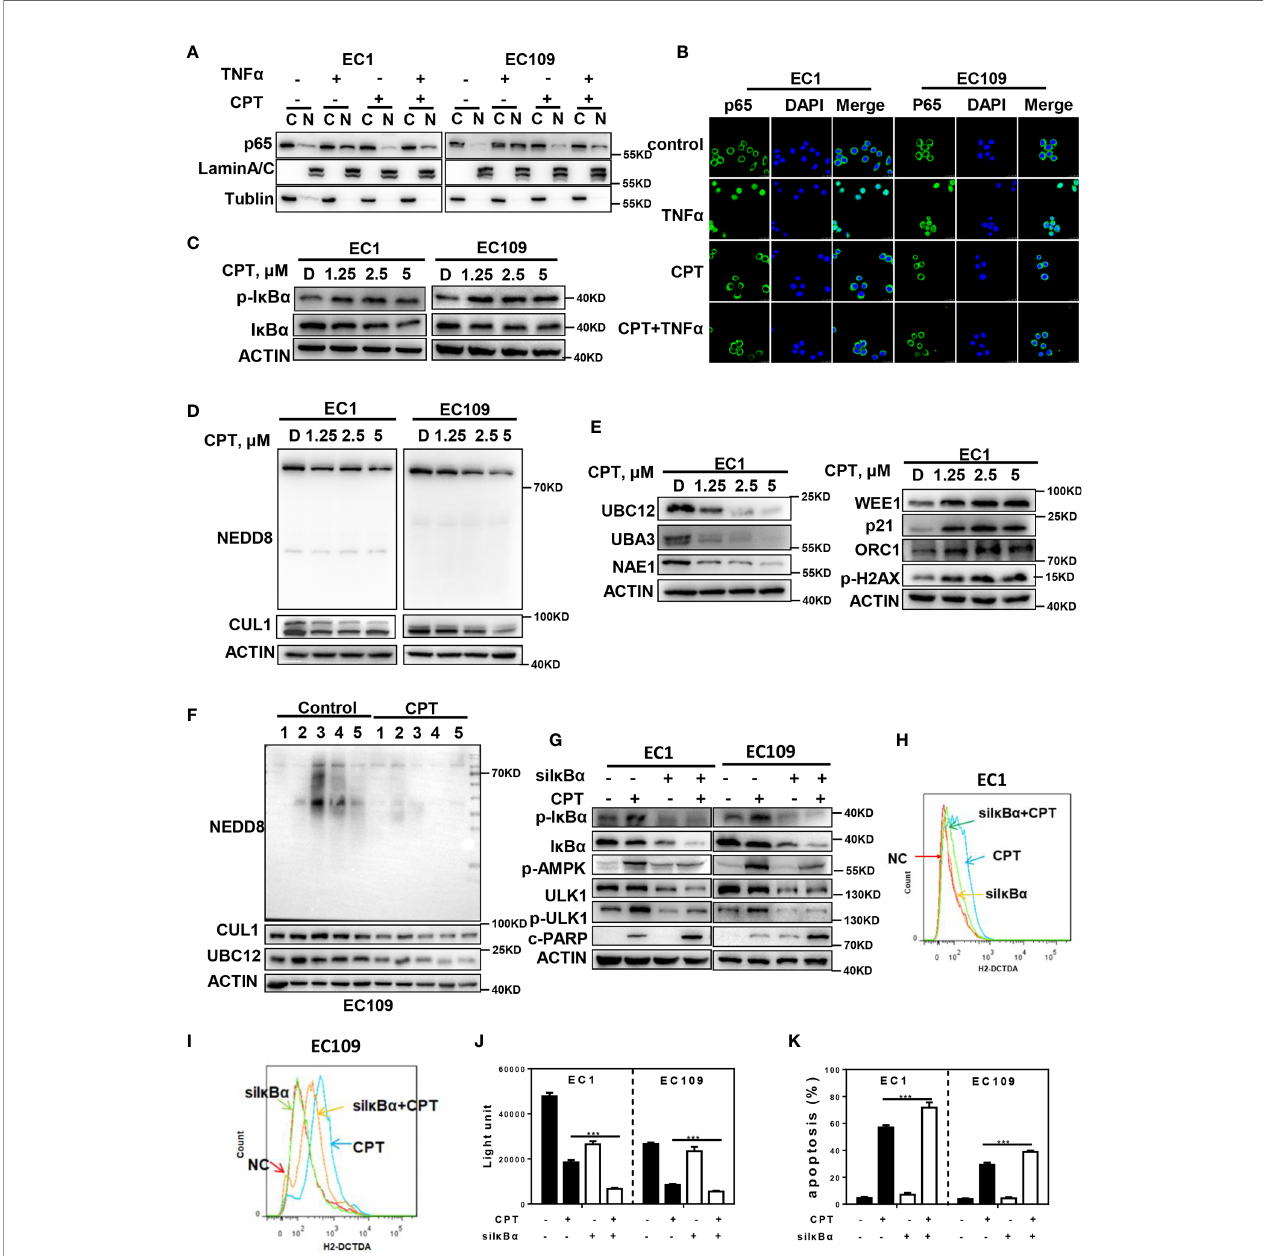
FIGURE 5 | ROS-mediated autophagy is attributed to p- I k B a accumulation by neddylation inactivation. (A – C) CPT inhibited the activation of NF- k B pathway. (A, B) CPT prevented p65 NF- k B translocation to the nucleus induced by TNF a . ESCC cells were cultured in the presence or absence of 2.5 m mol/L CPT (12 h) and stimulated concurrently with TNF a (100 ng/ml) for 30 min. (A) p65 isoform of NF- k B was determined by western blot analysis using nuclear (N) and cytosolic (C) fractions of ESCC cells treated as indicated. Lamin A/C and Tubulin were analyzed to demonstrate the presence of nuclear and cytosolic fractions,